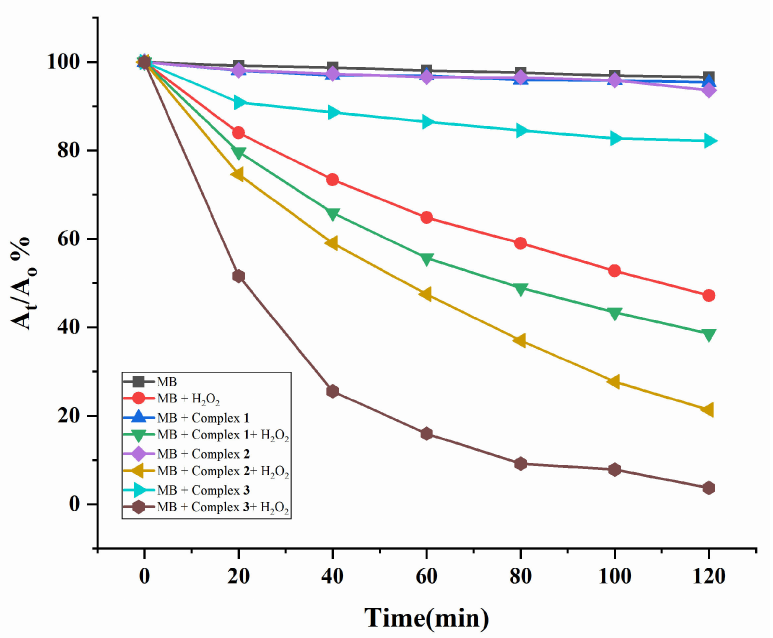
Figure 10. Photodegradation rates of MB solution under UV